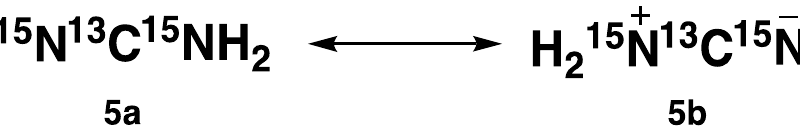
Figure 1. Resonance forms of compound 5 (cyanide ( 5a ) and carbodiimide ( 5b )).